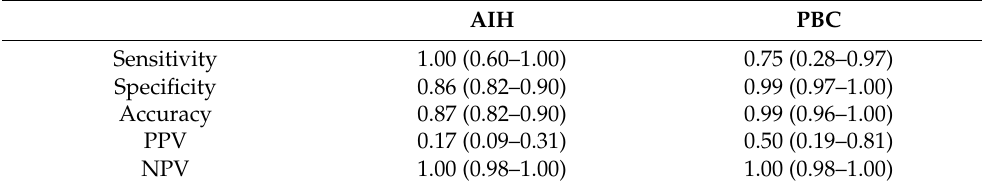
Figure 1. Diagrams illustrating the performance of the diagnostic AIH criteria ( A ) and PBC guidelines ( B ) among our study population. AIH = autoimmune hepatitis; SLE = systemic lupus erythematosus; PBC = primary biliary cholangitis; LFTs = liver function tests. Table 2. Performance of the simplified diagnostic AIH criteria and the recent PBC guidelines [44,45] in the study population to identify SLE patients with confirmed AILD. Cut-off for the AIH criteria was set at ≥ 6 points (representing “probable AIH”). 95% confidence intervals are shown in paren- theses.